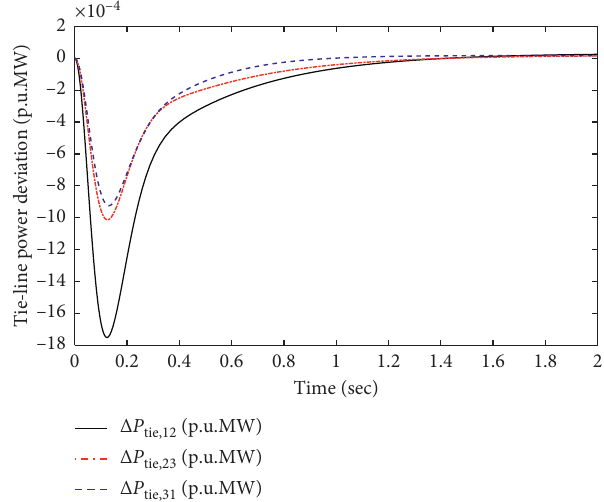
Figure 3: Tie-line variation of the